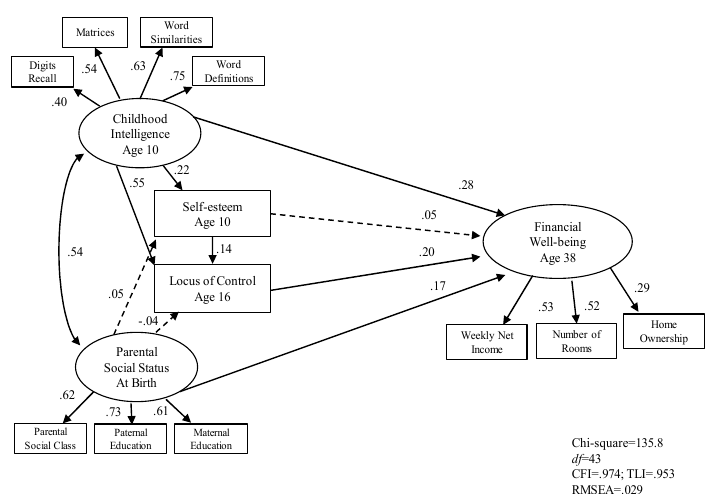
Figure 2. SEM Model 1 early indicators associated with adult financial well-being in female sample ( n = 2515).